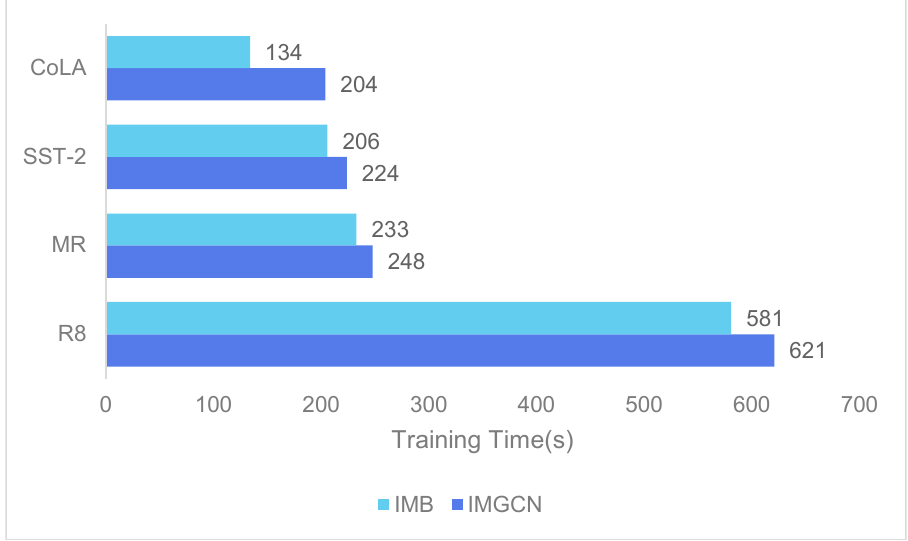
Figure 6. Average training time per epoch for different models on different datasets.